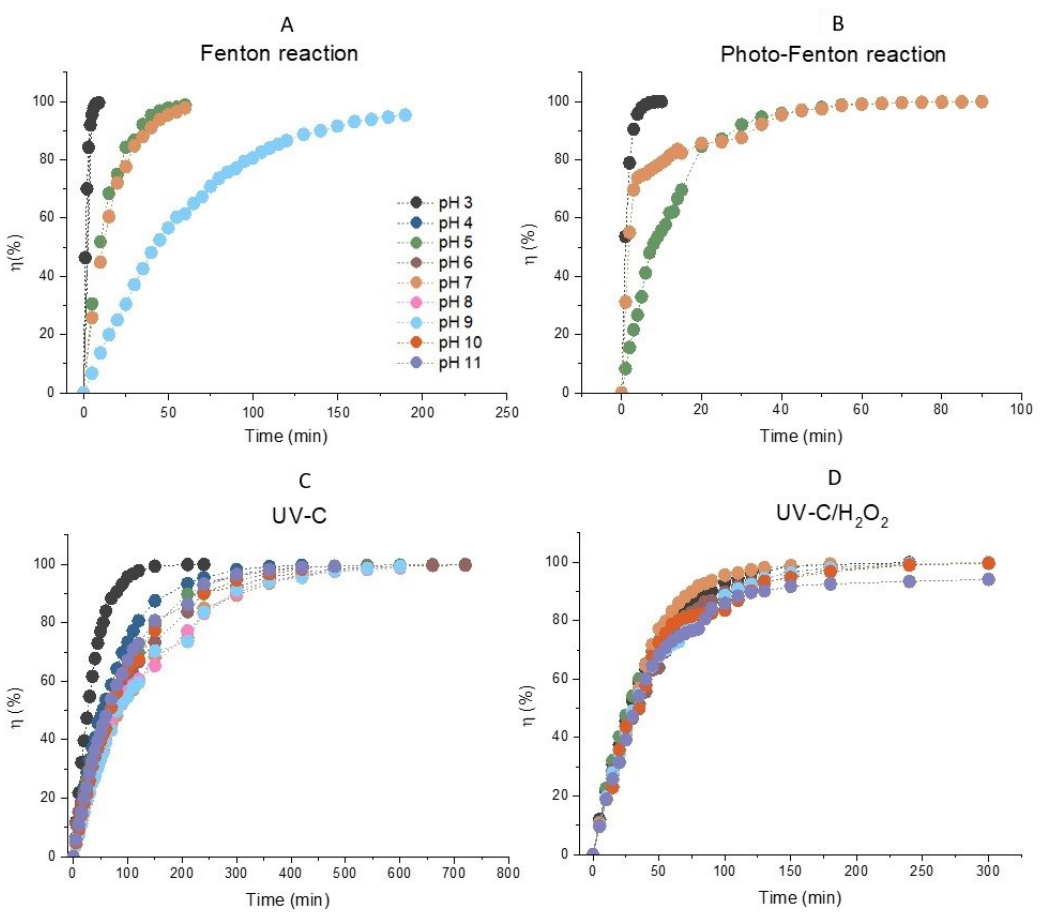
Figure 1. The dependences of efficiency of decolorization of model wastewater containing Acid Blue 80 over time in the homogeneous phase for the reaction systems. ( A ) Fenton oxidation (H 2 O 2 /Fe 2+ ), ( B ) photo-Fenton oxidation (H 2 O 2 /Fe 2+ /UV), ( C ) simple photolysis AB80 UVC, ( D ) photochemical oxidation (UVC/H 2 O 2 ). The initial concentration of AB80 was 1 × 10 − 4 mol/L. The spectrophotometric kinetic measurements were done at t = 25 °C, λ anal = 627 nm and in the pH range 3–11.